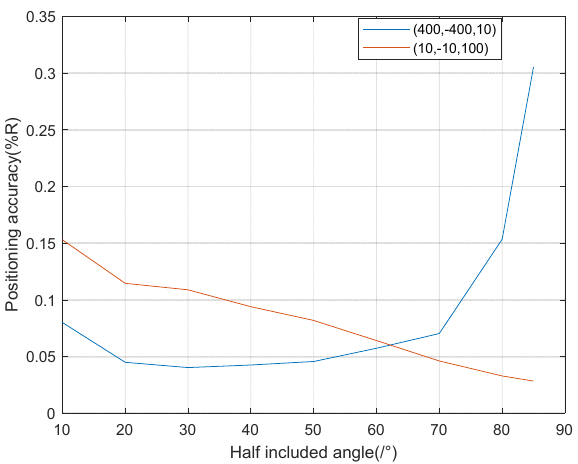
Figure 7. Positioning accuracy of stereo array 1 at different half included angles.